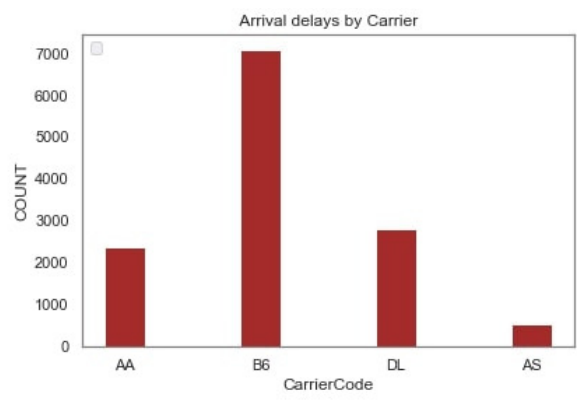
Fig. 6. Arrival delay by